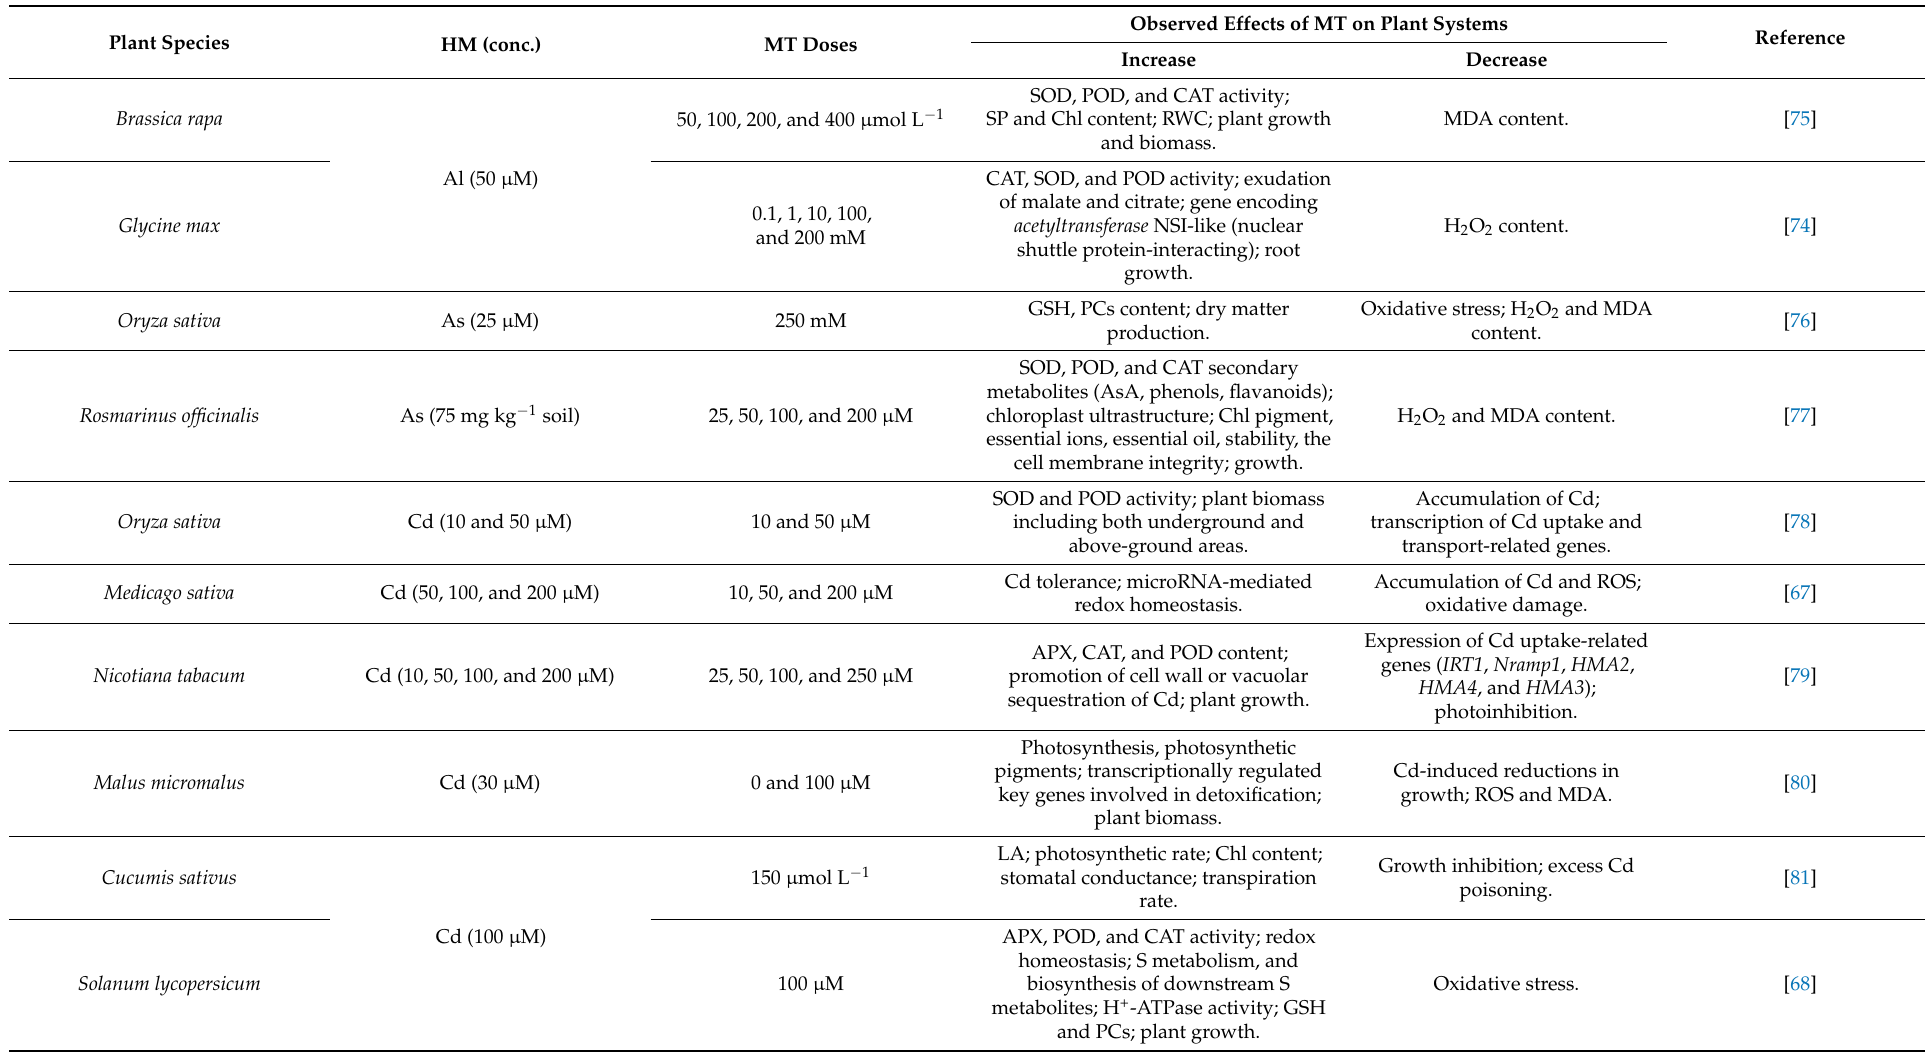
Table 2. Role of exogenous melatonin in plants exposed to various HM